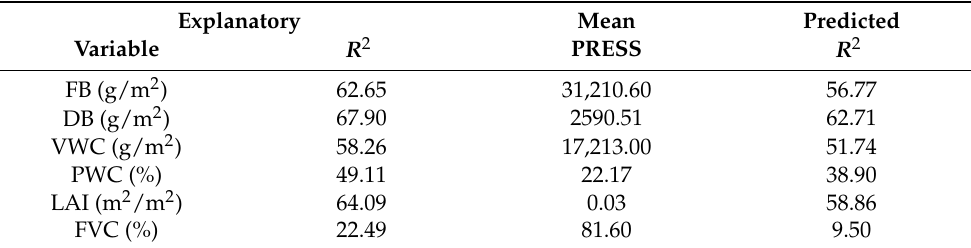
Table 6. Predictive capacity of the PLS analysis for each of the response variables of VBT, VT, VR and VO associations for three components.